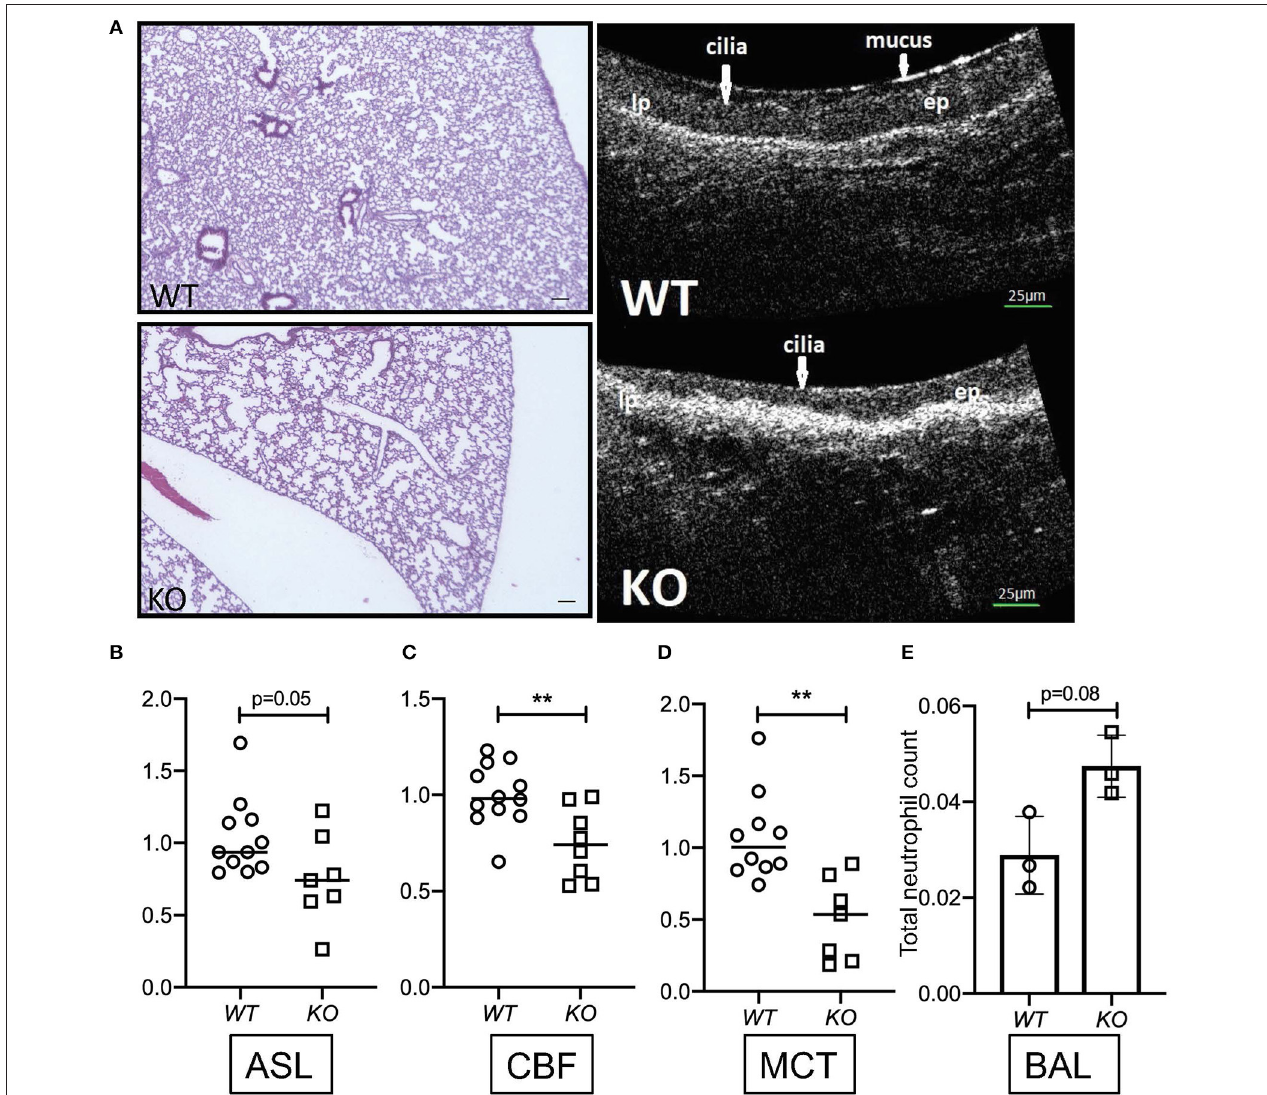
FIGURE 1 | (A) Representative images showing hematoxylin staining of whole lung sections from kl − / − (KO) and kl + / + (WT) mice (4X magnification, scale bar = 100 µ m) and representative images of µ OCT recordings from kl − / − (KO) and kl + / + (WT) tracheas. (B) Comparison of fold changes in airway surface liquid (ASL) depth, (C) ciliary beat frequency (CBF), and (D) mucociliary transport ex vivo from excised tracheas of kl − / − (KO) and kl + / + (WT) mice using µ OCT. (E) Bronchoalveolar lavage fluid (BALF) analysis showing a trend increase of total neutrophil cell count in three representative WT and KO mice. Statistics: Student’s t -test showing mean ± S.D. with ** p < 0.01, as indicated in appropriate graphs ( n = 7–11- animals per group).